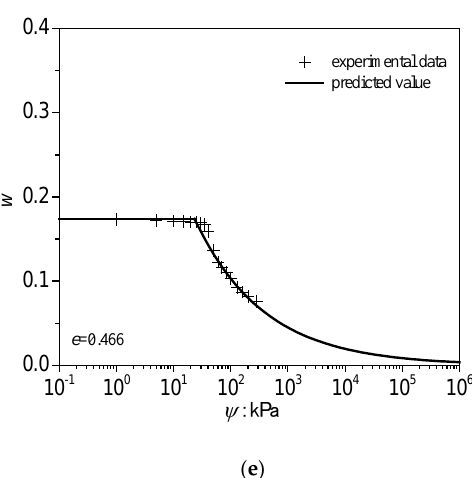
Figure 14. Measured and predicted SWCCs for Saskatchewan silt specimens (T1) at deformed state at ( a ) e = 0.540; ( b ) e = 0.528; ( c ) e = 0.501; ( d ) e = 0.483; ( e ) e = 0.466 (data after Huang [43]). The void ratio of the specimen at the loosest state e 0 = 0.525 for T2 was regarded as the initial void ratio at reference state. The calibrated SWCC parameters of Saskatchewan silt of T2 at reference state for the second tests ( D 0 = 2.604, Ψ a0 = 17.71 kPa) were obtained as shown in Figures 15 and 16, respectively. The corresponding air-entry values at deformed state are presented in Table 2.